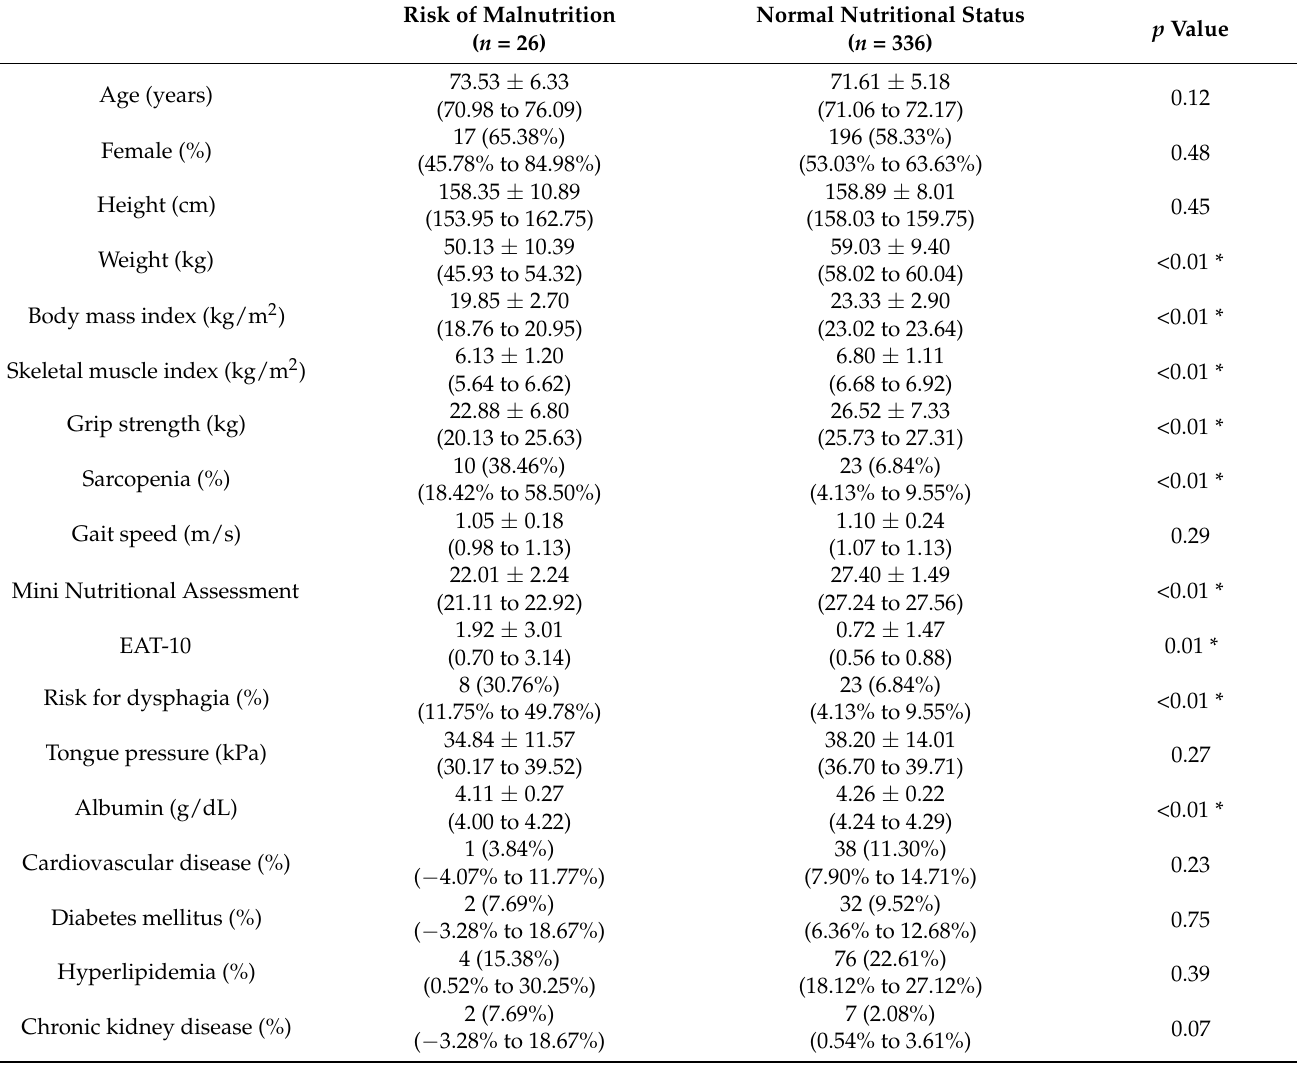
Table 1. Characteristics of the study